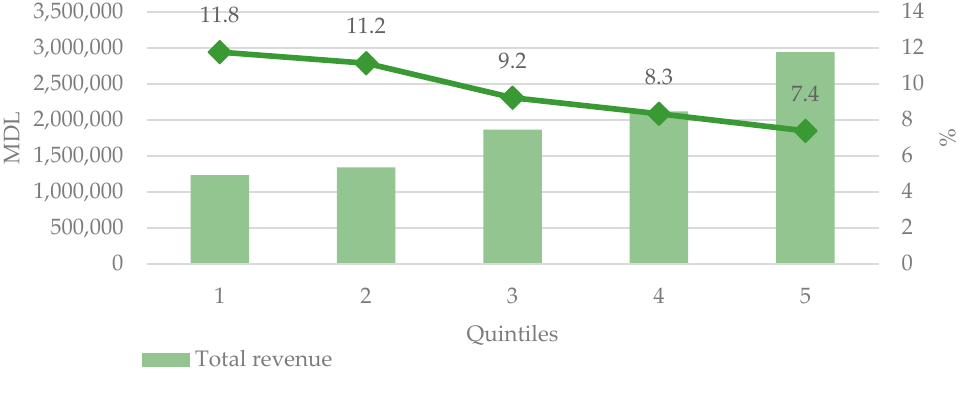
Figure 7. Forest dependence (products collected and products purchased) of households in sampled villages by wealth quintile.